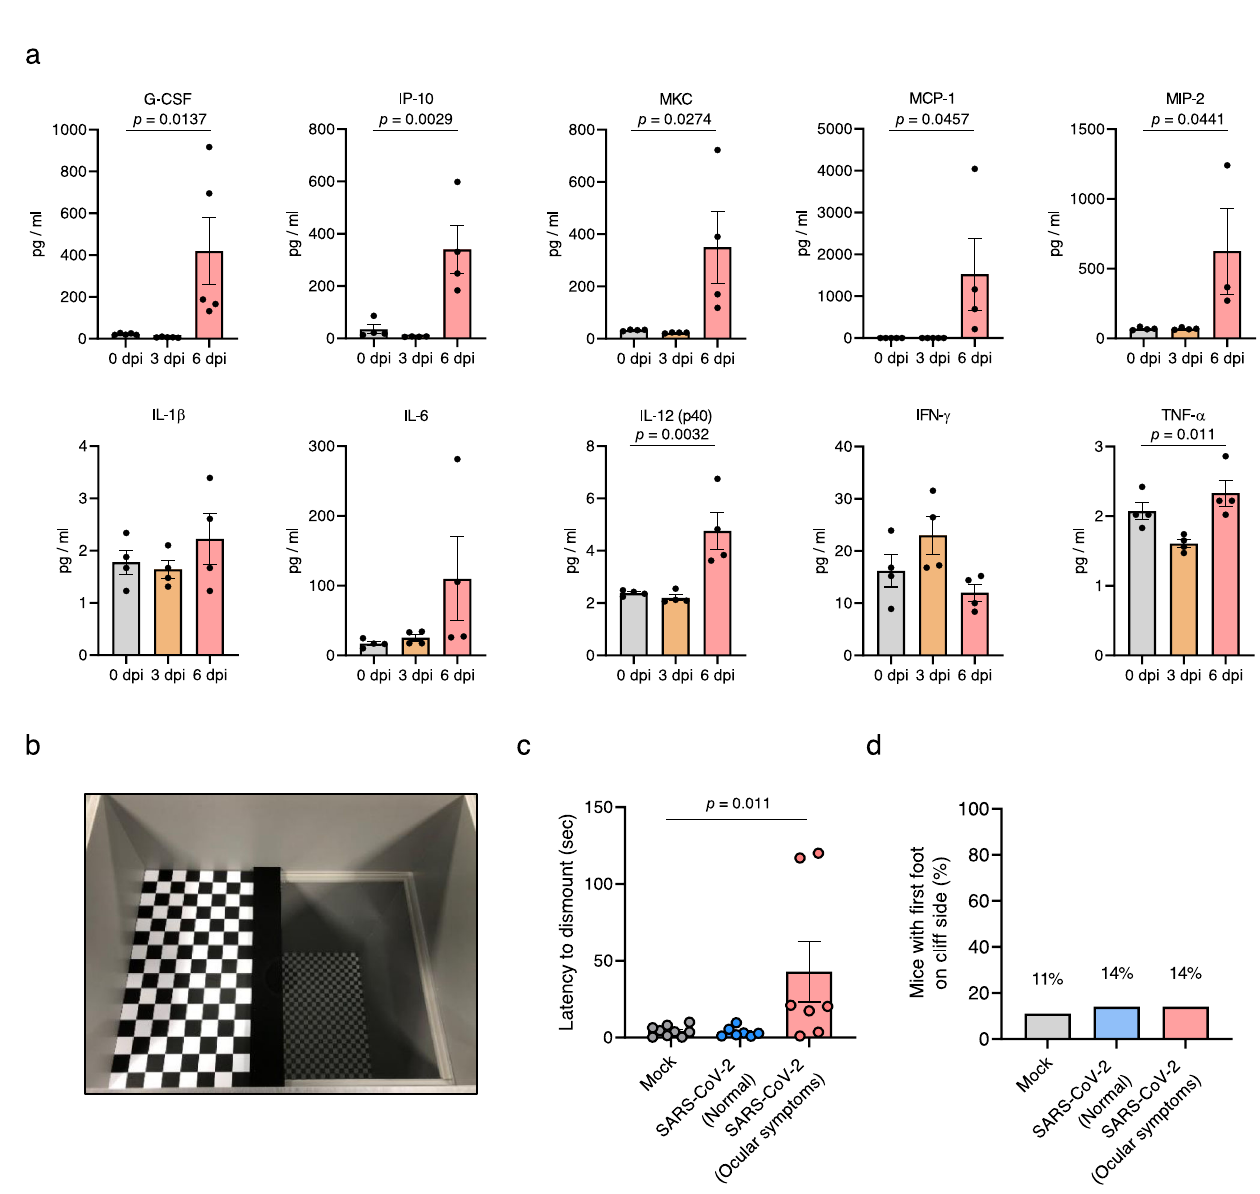
Fig.3|MultiplexcytokineanalysisoftheeyesandthevisualclifftestforSARS- Cov-2-infected mice. a The chemokine and cytokine levels in the eyes, including appendages, in SARS-CoV-2-infected mice, were measured using multiplex immuno-analysis ( n =4 per indicated dpi; 0 dpi, grey; 3 dpi, yellow; 6 dpi, red). G-CSF granulocyte-macrophage colony-stimulating factor, IP-10 C-X-C motif che- mokine 10 (CXCL10), MKC mouse keratinocyte-derived chemokine, MCP-1 mono- cyte chemoattractant protein-1 (CCL2),MIP-2macrophage-in fl ammatoryprotein-2